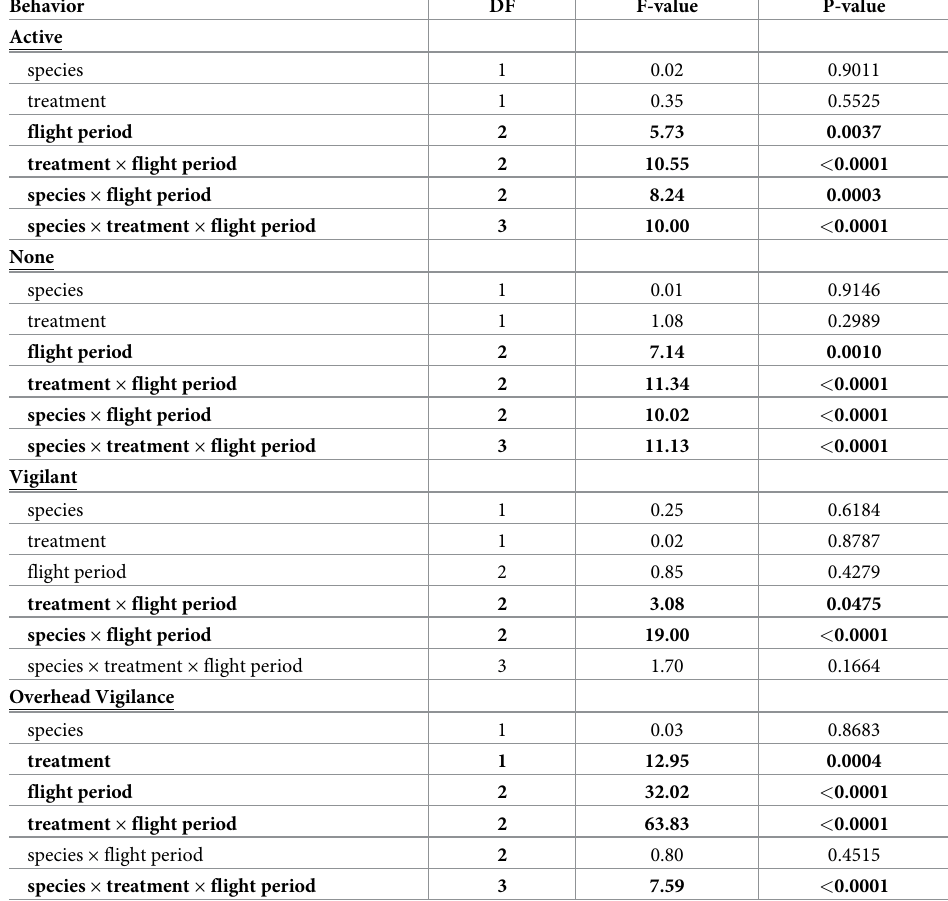
Table 2. Model results for proportion of time spent on each behavior. Fixed effects include species (blue-winged teal and northern shoveler), treatment (flown and control), flight period (before during after), and the interactions (treatment × flight period, species × flight period, species × treatment × flight period). Bold highlights denote statistical